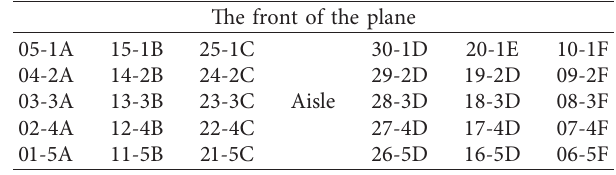
Table 1: The numbers of seats in the aircraft. Front of a plane